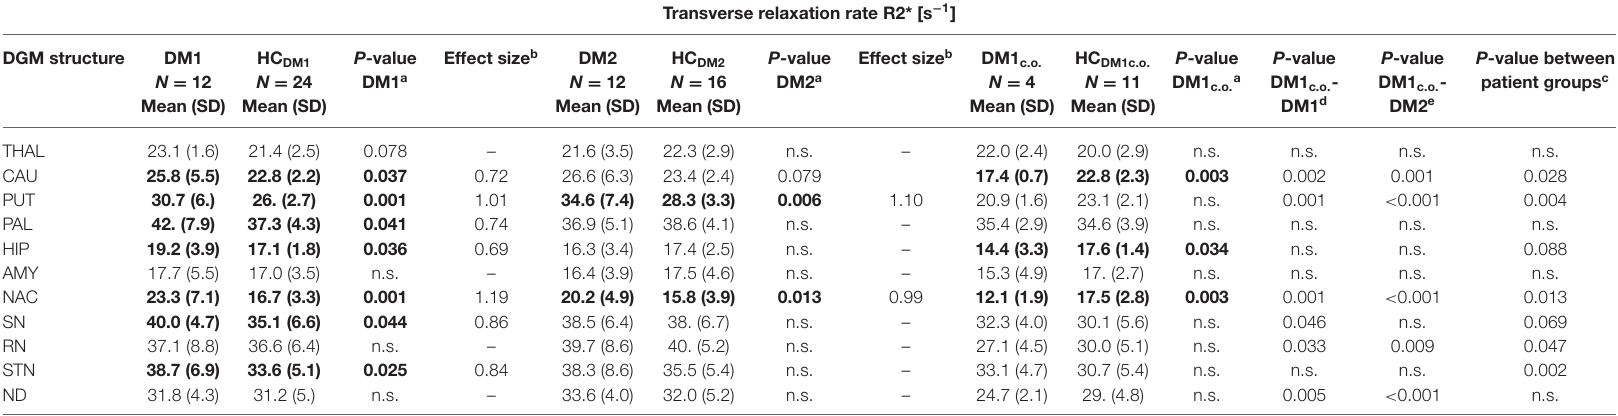
TABLE 4 | Group comparisons of the transverse relaxation rate R2 * between DM1, DM1c.o., DM2, and age matched controls (HC).